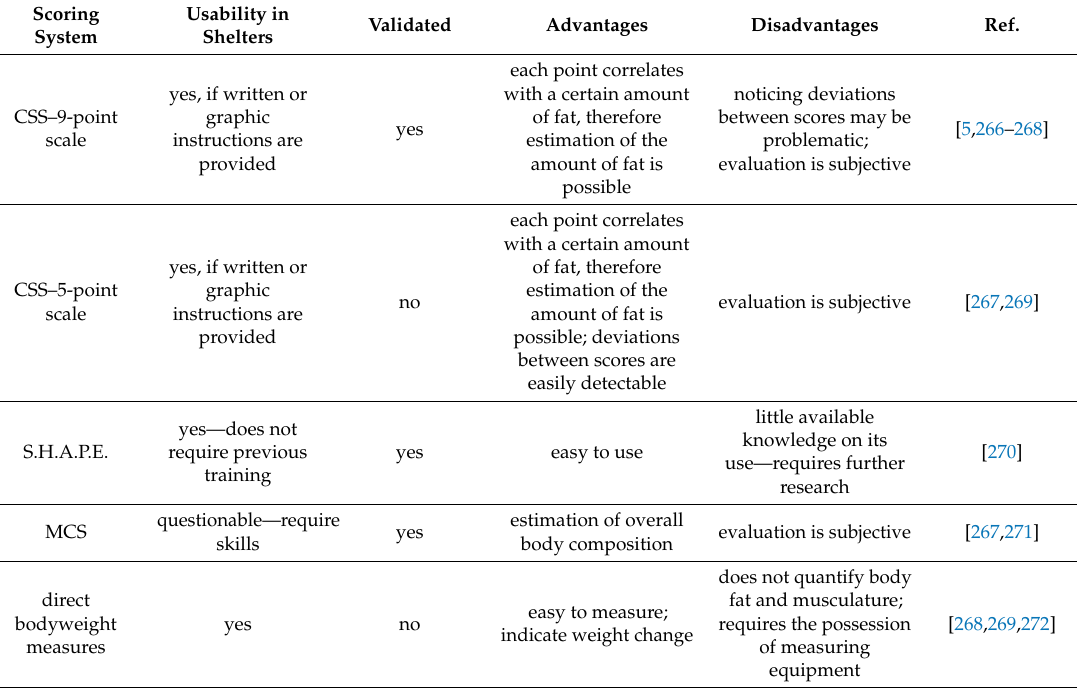
Table 3. Practicality of methods evaluating body condition of